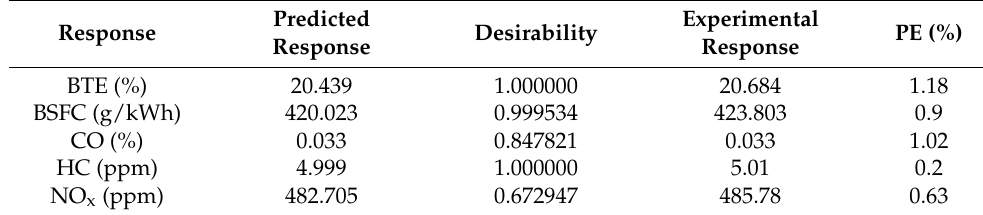
Table 10. Validation test for